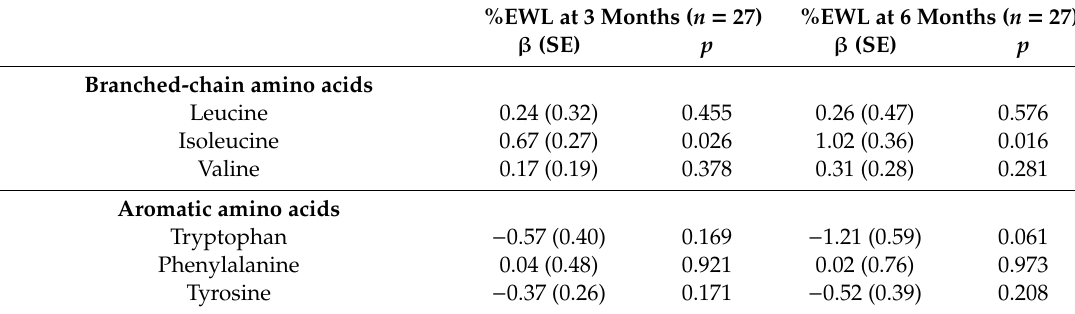
Table 3. Association between baseline amino acid metabolites and %EWL at three and six months after sleeve